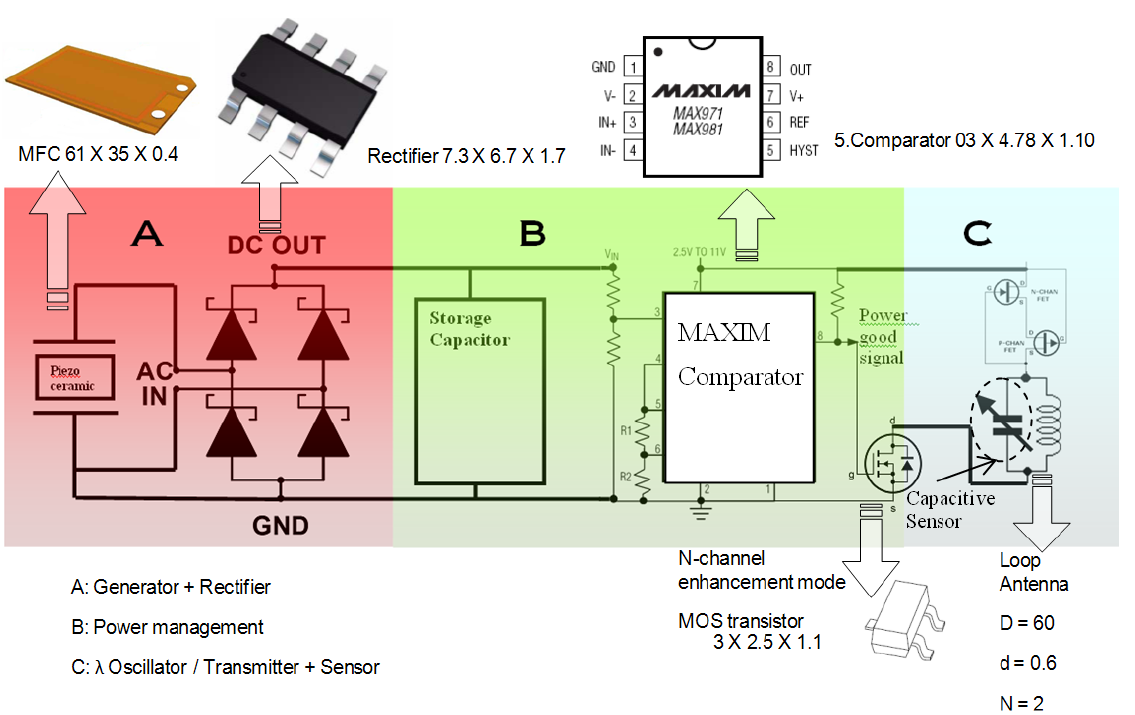
Figure 24. Schematic of the wireless sensor node